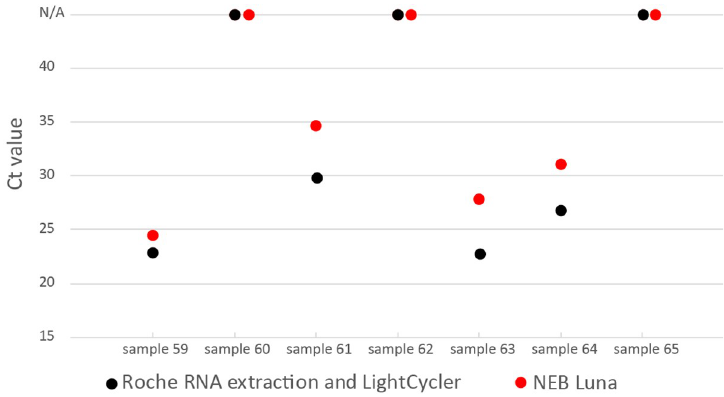
Fig 2. Roche RNA extraction/RT-qPCR and NEB Luna RT-qPCR of seven reference samples. Dots at N/A show no amplification of the viral target.